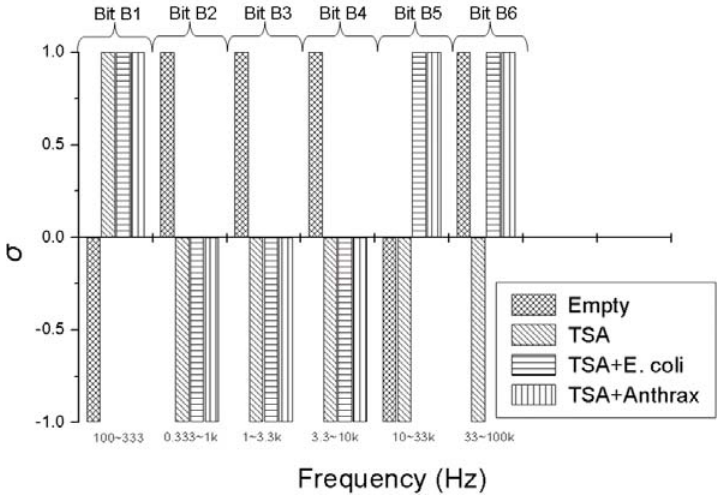
Figure 8. The spectra in Figures 5-7 yield the same 6-bits